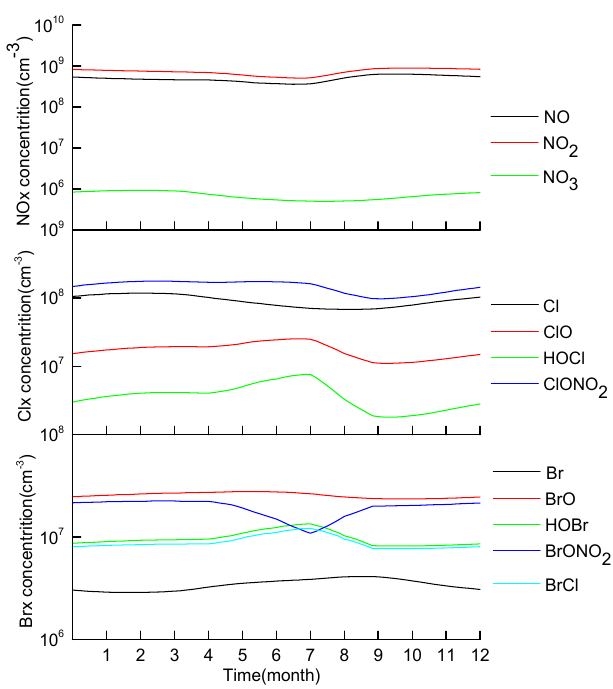
Figure 7. Changes in NOx/Clx/Brx over time over the Tibetan Plateau.